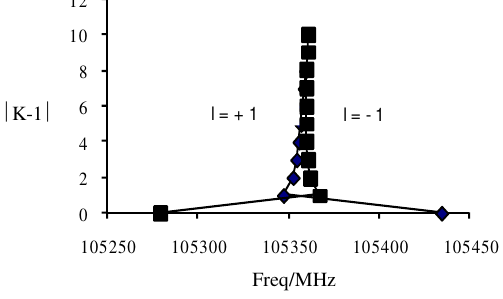
Figure 6. Fortrat diagram for (CH